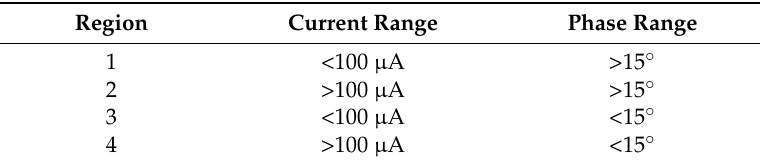
Figure 25. Two-dimensional scatter plot of the current and phase difference. Table 4. Coordinate area